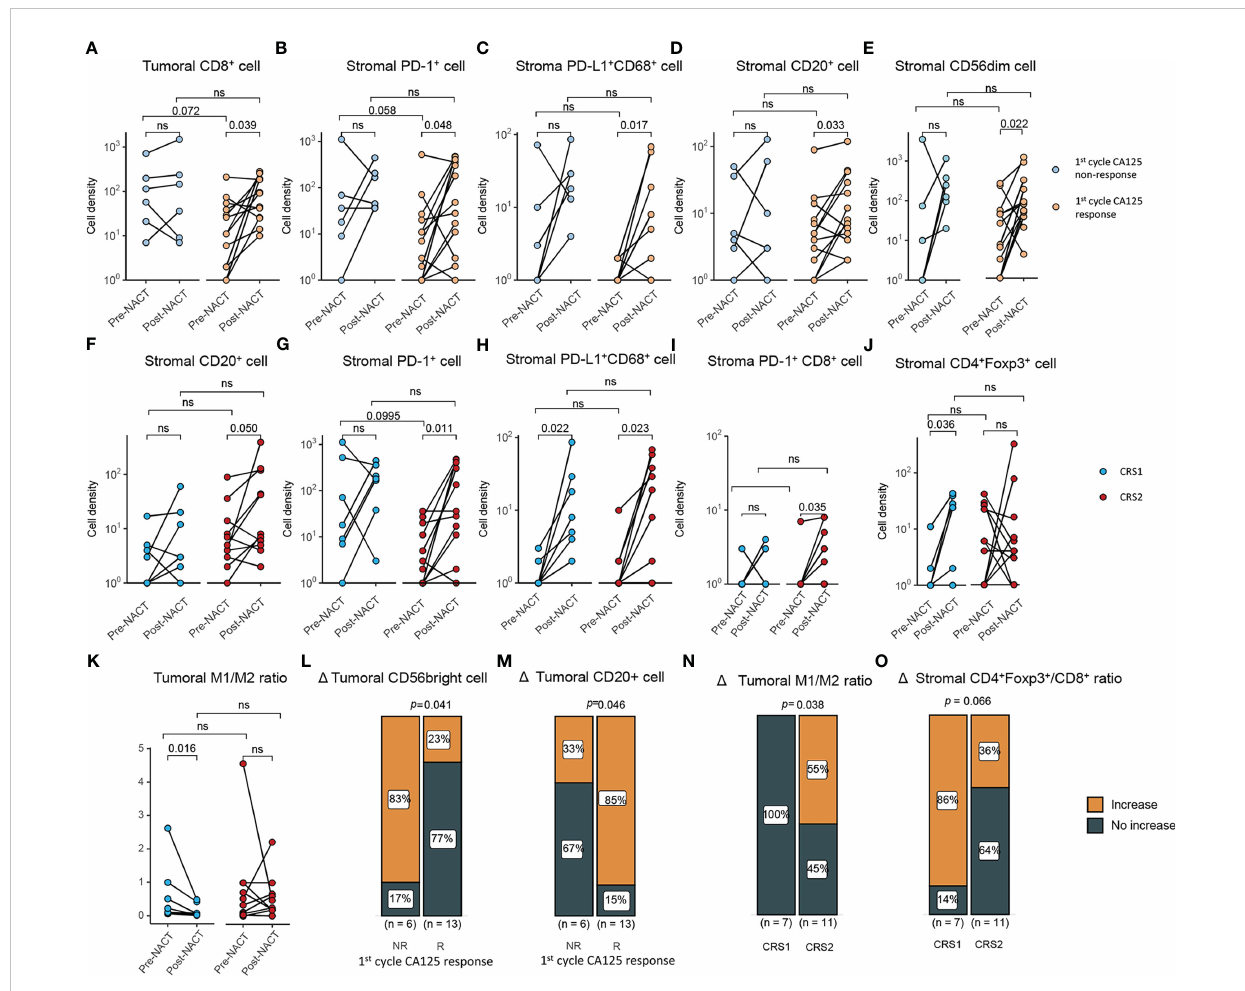
FIGURE 2 Correlations between the change of tumor immune microenvironment and response to NACT. (A – D) Comparison of density of (A) tumoral CD8 + cells, (B) stromal PD-1 + cells, (C) stromal PD-L1 + CD68 + cell, (D) stromal CD20 + cell, (E) CD56dim cells between pre- and post-NACT tumor samples in CA125 responders and CA125 non-responders (CA125 responders, n=13; CA125 non-responders, n=6). (F – J) Comparison of density of (F) stromal CD20 + cell (G) stromal PD-1 + cells, (H) stromal PD-L1 + CD68 + cell, (I) stromal PD-1 + CD8 + cell, (J) stromal CD4 + Foxp3 + cells between pre- and post-NACT tumor samples in CRS1 and CRS2 group (CRS1, n=7; CRS2, n=11). (K) Tumoral M1/M2 macrophage density ratio of pre- and post-NACT tumor samples. (L, M) Density change in CD56 bright cells (L) and CD20+ cells (M) between the CA125 responders and non-responders